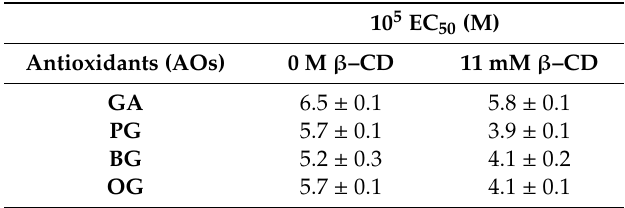
Table 2. 2,2–diphenyl–1pycrilhydrazyl (DPPH • ) radical scavenging activity of gallates tested: gallic acid (GA), propyl gallate (PG), butyl gallate (BG), and octyl gallate (OG) in the absence and in the presence of β –CD (11 mM), T = 25 ± 1 ◦